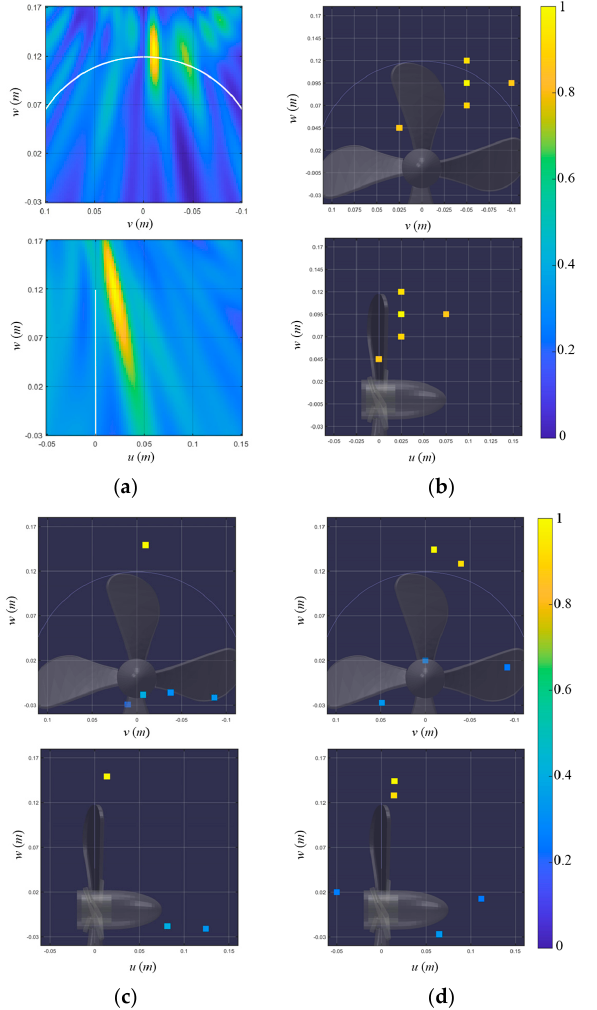
Figure 13. Localization results of signal 3, which include the first and second cavitation events, using ( a ) a conventional beamformer, ( b ) on-grid BSBL, ( c ) off-grid BSBL, and ( d ) pairwise off-grid BSBL. The localization results are displayed onto the 𝑣 – 𝑤 (looking from the stern side) and 𝑢 – 𝑤 (looking from the port side) planes to visualize the 3D cavitation localization results.